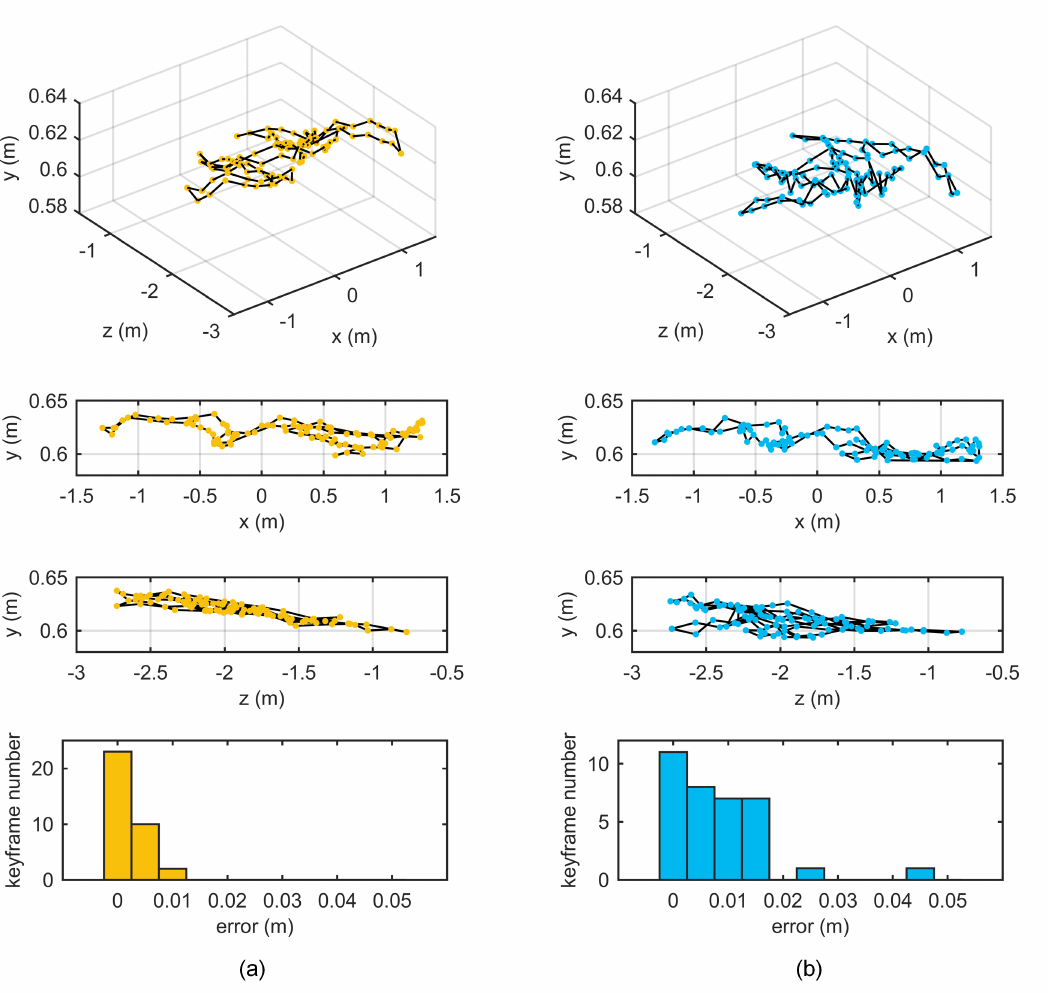
Figure 10. Comparison of keyframe positions between proposed method and NoPlanar method. (Axes scales are different): ( a ) proposed method; ( b ) NoPlanar method. The first row contains 3D keyframe positions. The second and third rows are side views of the first row. The last row is the distance histogram between the keyframe position and estimated move